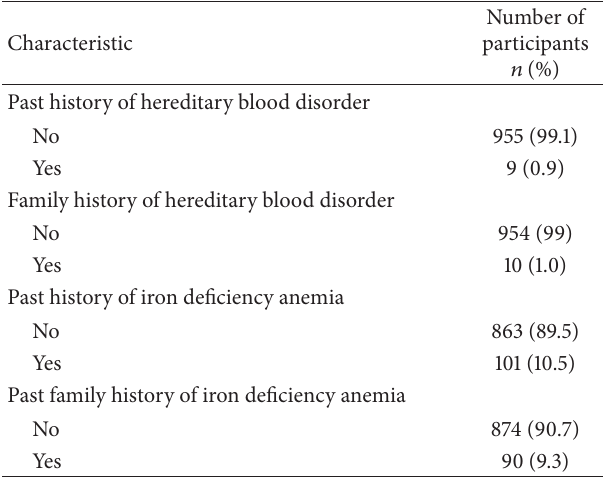
Table 3 is representing the unadjusted odds ratio of increasing BMI (OR 0.97, 95% CI 0.95, 0.98), absence of